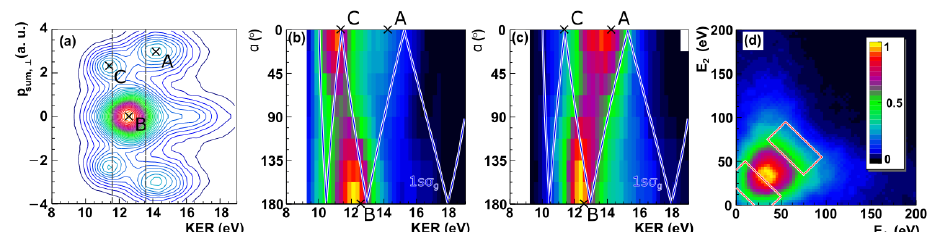
Fig. 1. Yield of protons created upon double ionization of H 2 as a function of kinetic energy release (KER) and the sum momentum of the two emitted electrons (a), the relative angle of the electrons (b, c). Distributions in (b, c) are made of events with low and high electron energy, respectively, as indicated in (d) which shows first and second electron energy correlation. Points marked by A, B, C indicate parallel (A and C) and anti-parallel (B) emission of the two electrons.